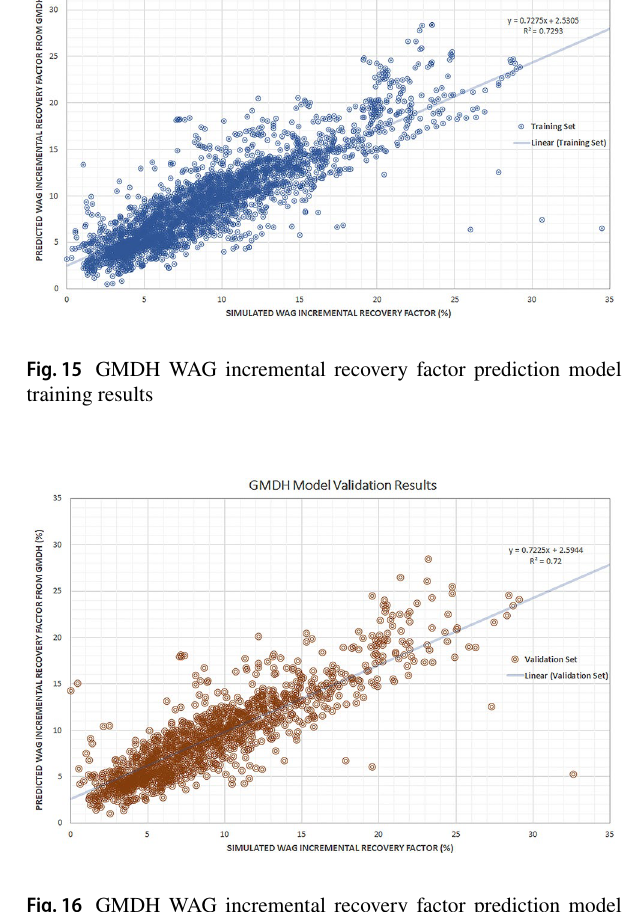
Fig. 16 GMDH WAG incremental recovery factor prediction model validation